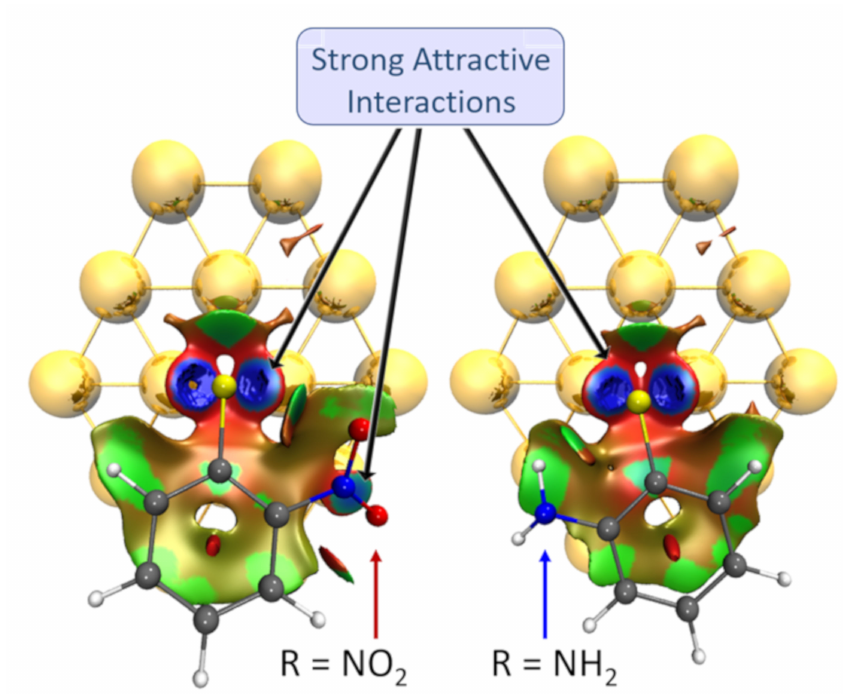
Figure 4. Graphical representation of the non-covalent interactions between the gold substrate and the phenyl-sulphonate ligands functionalized in ortho with –NO 2 and NH 2 substituents. (hydrogen—white; carbon—grey; sulfur—yellow; nitrogen—blue and the isovalue used as cuto ff was defined at